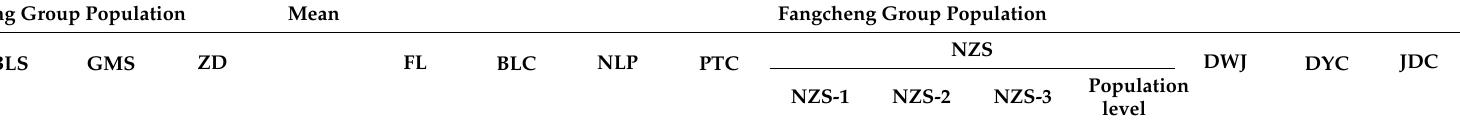
Table 3. Pairwise estimated values of F ST among (sub)populations of Camellia nitidissima